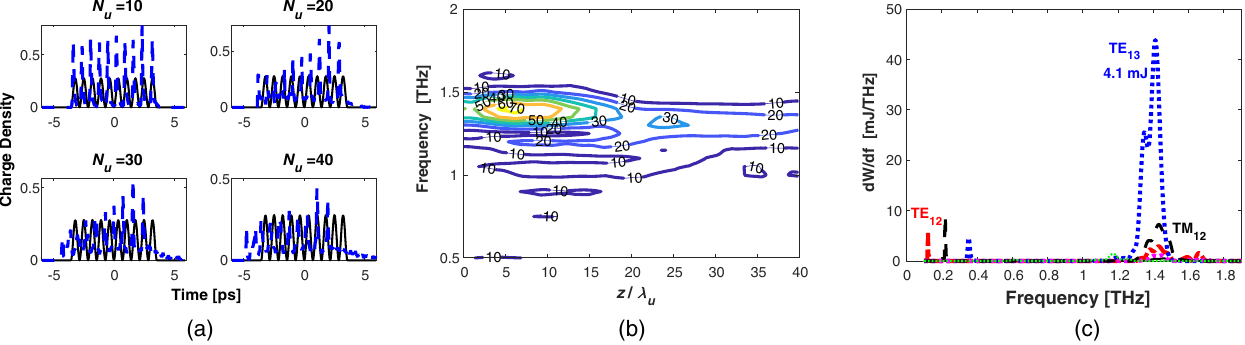
FIG. 8. Bunch with a charge of 5 nC and ten periods of unity modulation at a frequency of 1.4 THz in NMI regime (over-resonance guiding field of 75 kG): (a) charge density after 10 to 40 undulator periods, (b) contours of the bunching factor, and (c) radiation spectrum after 40 undulator periods.